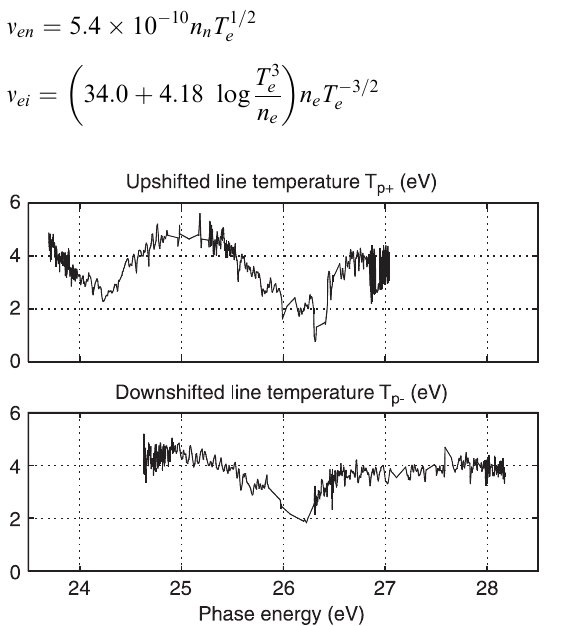
Fig. 5. The temperature T p (cid:135) and T p (cid:255) of the up- and downshifted plasma lines from the 1-h observation of Figs. 4 and 3 plotted as a function of their phase energy, respectively E / (cid:135) and E /